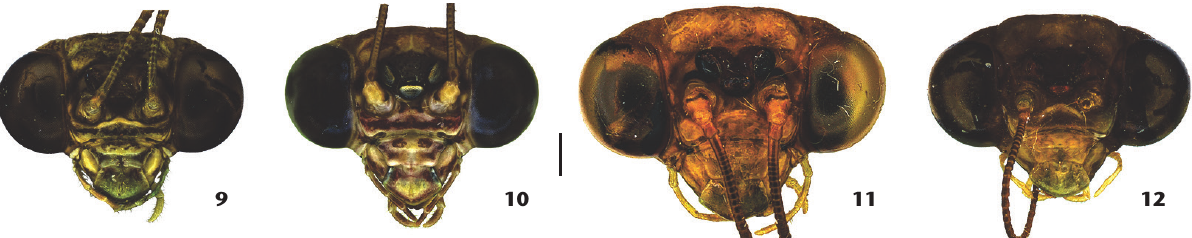
Figures 9-12. Head of males of Paraphotina (frontal view): (9) P . caatingaensis from Bahia, Brazil; (10) P . insolita from Meta, Colombia; (11) P . occidentalis from Coari, Amazonas, Brazil; (12) P . reticulata from Maranhão, Brazil. Scale bar: 1 elliptical; antennae filiform with scattered short setae, longer with longitudinal carina slightly marked; pronotal terminal than half of body; pedicel and scape clear; vertex convex in tubercle poorly developed with two distal spots, which may frontal view, higher than juxta-ocular tubercles; juxta-ocular be fused (Figs. 13-16). Fore coxae almost as long as metazona. tubercles slightly developed; eyes globose (Figs. 9-12); ocellar Forecoxae and trochanters smooth, with or without black spots. tubercle pale yellow to dark gray without developed expansions Fore femora mildly concave dorsally, generally with three spots in male; female ocelli located at center of a transversal carina; on anterior surface and arabesque marks in posterior surface; frontal shield more than three times wider than high, central 13-14 anteroventral spines, the even spines generally with black part of dorsal margin convex. Pronotum with arabesque marks, spot at base, rarely at distal odd spines; 5 posteroventral spines, elongated, smooth; prozona with anterior margin convex, lateral black at base; 3 discoidal spines, second spine with an anterior margins subparallel; metazona 2.5 times longer than prozona, black spot at base. Fore tibiae usually with three black spots on ZOOLOGIA 33(6): e20160055 | DOI: 10.1590/S1984-4689zool-20160055 | December 15, 20164 / 13